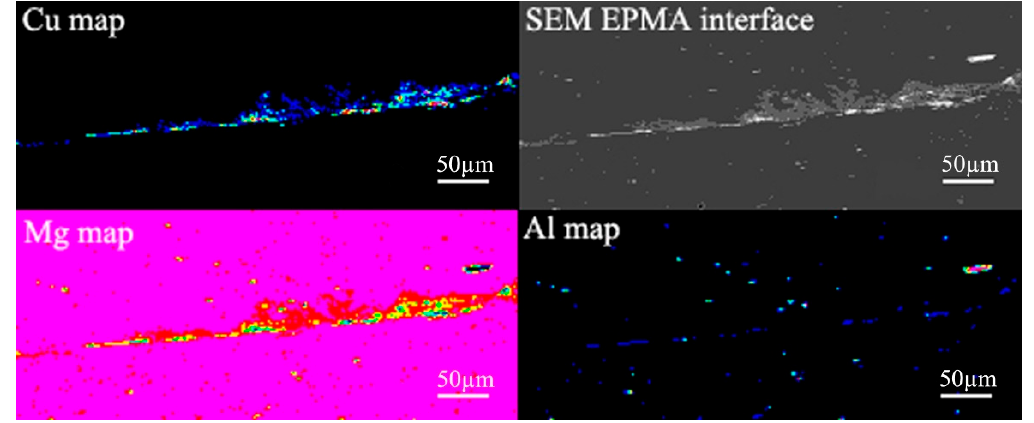
Figure 13. EPMA analysis on joint type B (1100 J) interface: Map of Mg, Cu and Al.